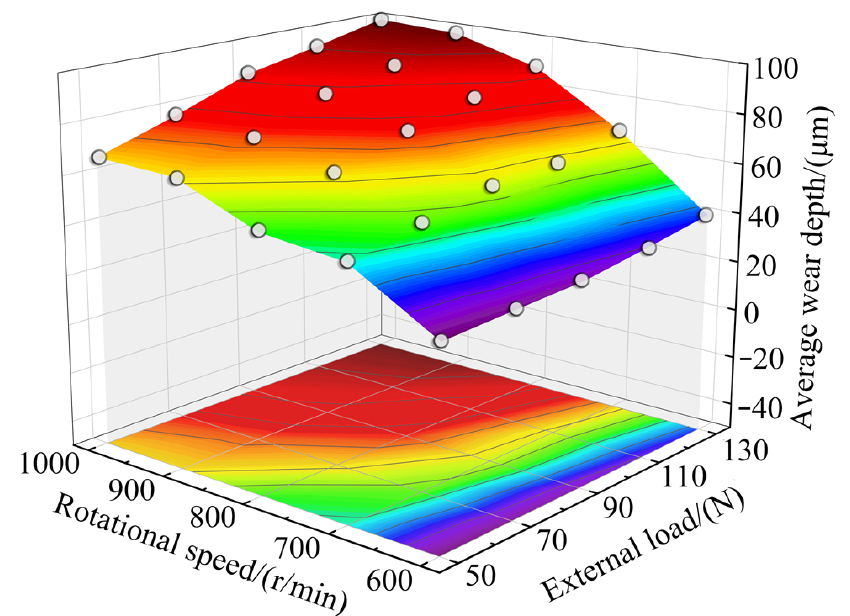
Figure 14. Effect of friction parameters on surface wear depth. (Different colors represent the difference in average wear height, dark red represents the maximum value, and purple represents the minimum value.)